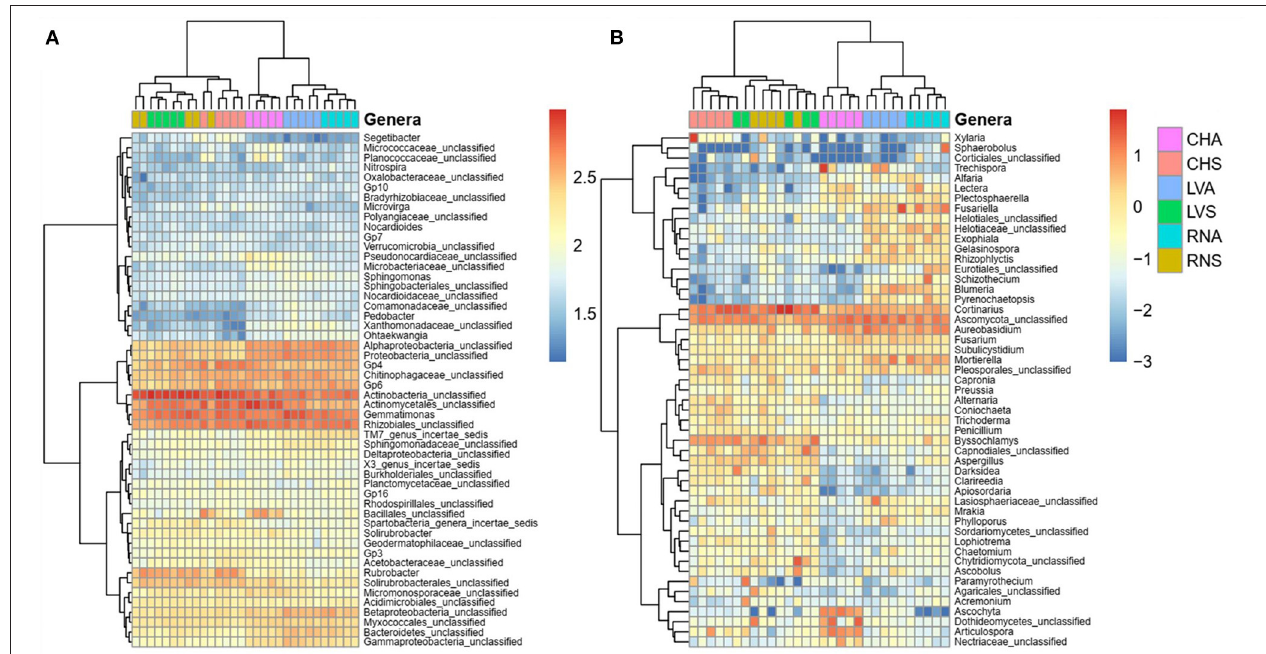
FIGURE 6 | Heatmap showing the abundances of the 50 most abundant (A) bacteria/archaea and (B) fungi genera in irrigated agriculture and steppe soils under. Data were centered and scaled to the mean of each taxon’s log-transformed relative abundance. Top dendrogram cluster samples according to the community composition. Side dendrogram cluster taxa according to their relative abundance distribution across